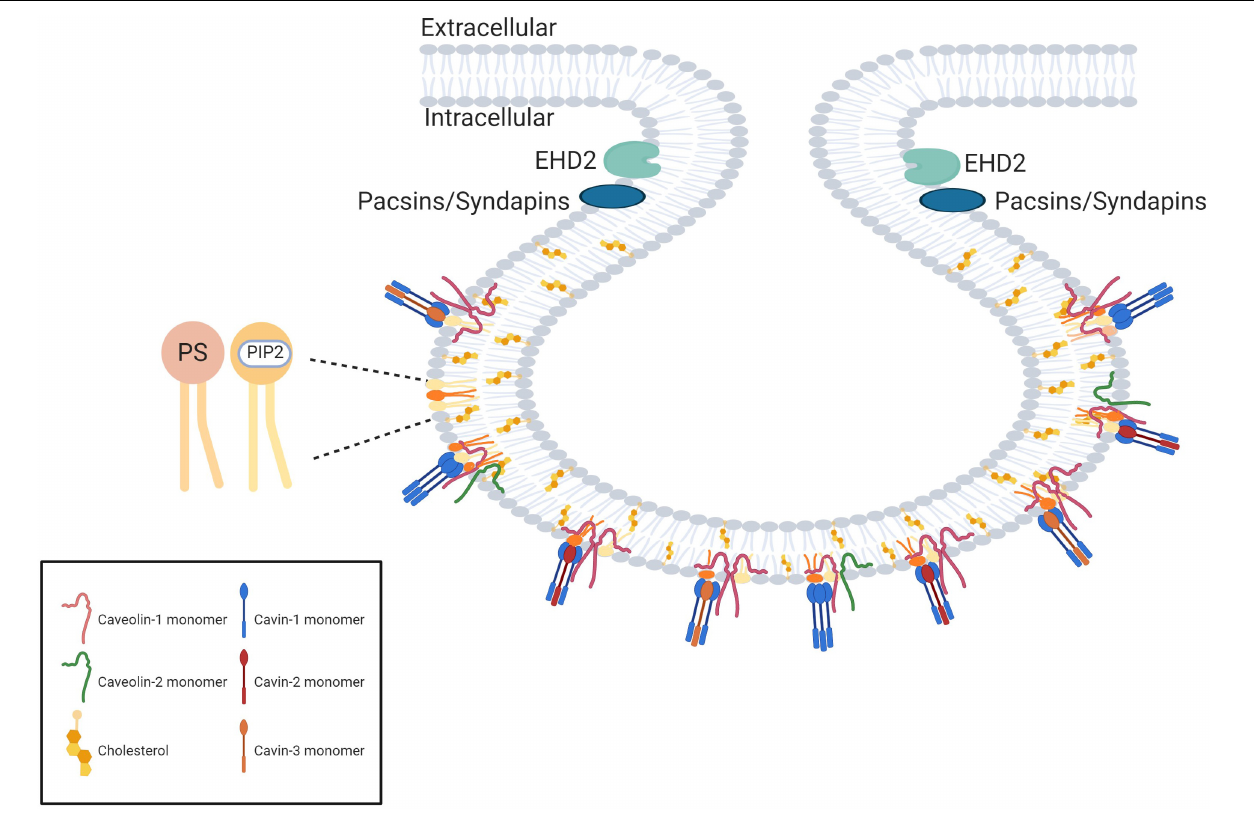
FIGURE 3 | The protein scaffold of caveolae. The proteins forming the caveolae coat are named caveolins and cavins. The main proteins of the coat are caveolin-1 (which oligomerizes in homooligomers or heterooligomers with caveolin-2) and cavin-1 which forms homotrimers or heterotrimers with cavin-2 or cavin-3. The curvature of the neck of the caveolae is dependent on EH-domain containing protein 2 (EDH2) and pacsins. Created with